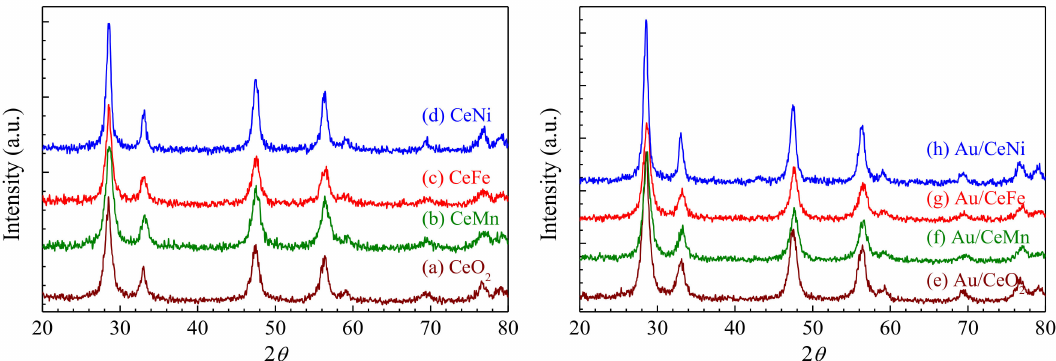
Figure 1. XRD patterns of CeO 2 , CeM mixed oxides with different dopants and corresponding supported Au/CeM catalysts: ( a ) CeO 2 ; ( b ) CeMn; ( c ) CeFe; ( d ) CeNi; ( e ) Au/CeO 2 ; ( f ) Au/CeMn; ( g ) Au/CeFe; ( h ) Au/CeNi.